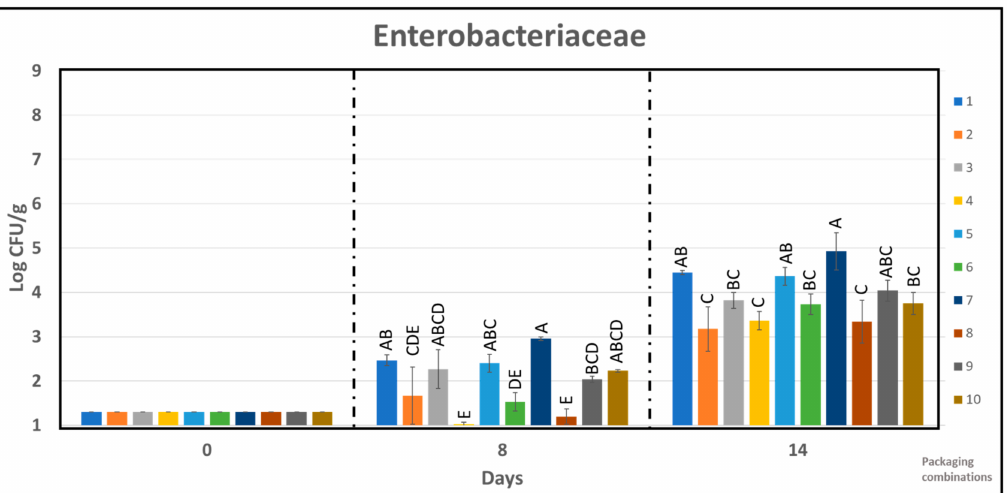
Figure 7. The effect of packaging combinations on the Enterobacteriaceae counts in chicken samples during storage time of 14 days. One-way analysis of variance Tukey comparison is performed separately at sampling point 8 and 14. Tukey group is represented by upper case letters, samples which do not share the same letter are significantly